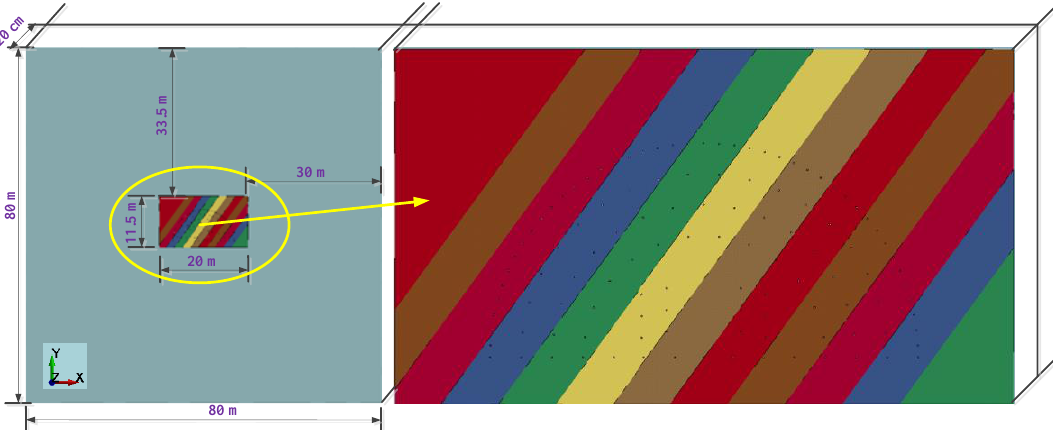
Figure 8. ( a ) Tunnel face of Zigaojian Tunnel. ( b ) Visible bedded joints.